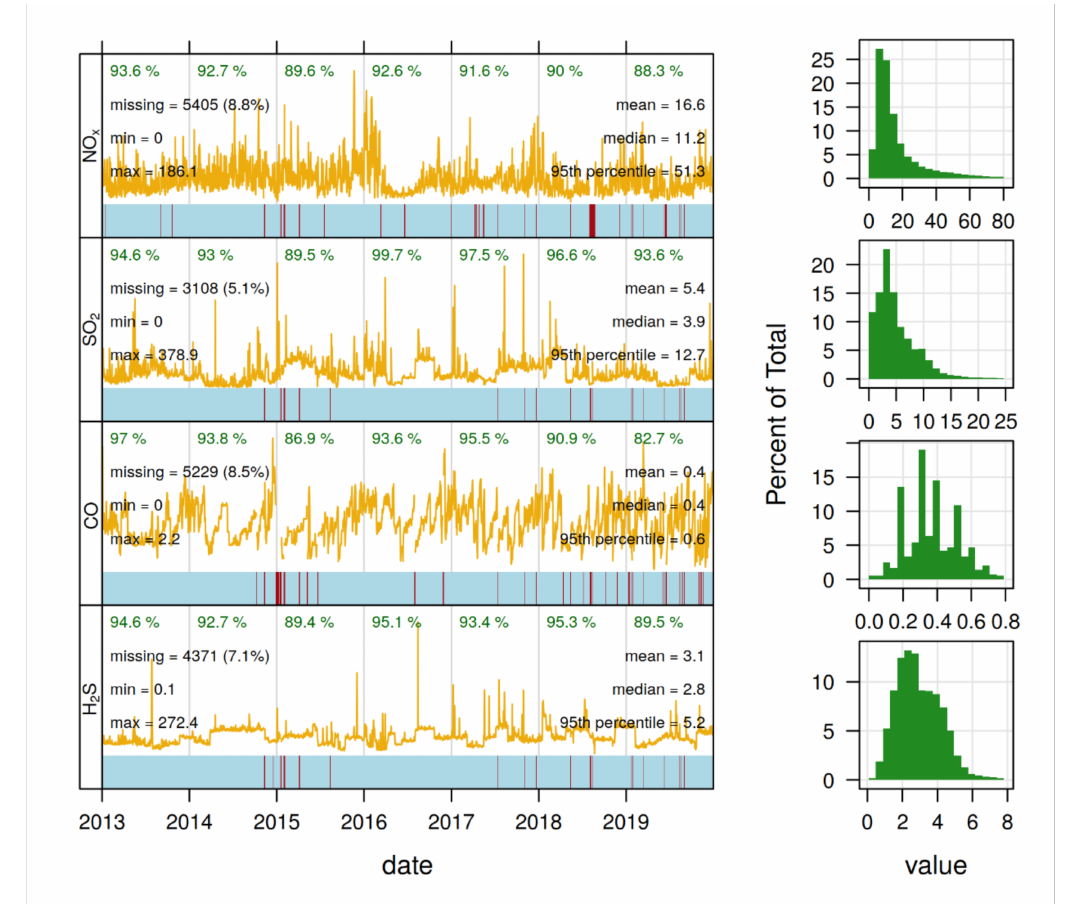
Figure 2. Left panel: the time series data of hourly NOx, SO 2 , CO, H 2 S values (yellow lines,) and the availability and non-availability of the data (respectively the blue and red colors on the rectangular bar at the bottom of the plots). The minimum, maximum, number, and percent of missing data, mean, median and the 95th percentile for each variable plotted (in black). The percentage of the data captured for every year (in green) on the upper part of each year data plot. Right panel: the distribution of each species using a histogram plot over the selected